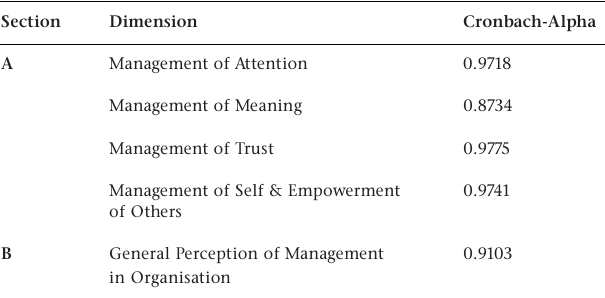
Figure 2: Gender Analysis of Sample